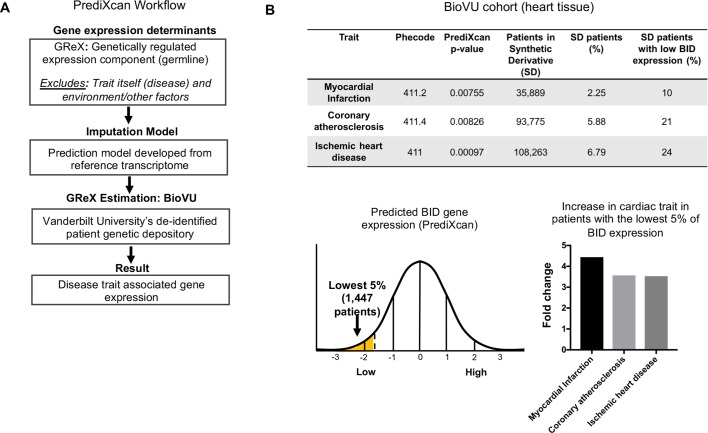
PrediXcan analysis of BID expression reveals a novel role in cardiac diseases.(A) Diagram of PrediXcan analysis workflow. PrediXcan estimates the genetically regulated component of gene expression (germline), excluding the impact of the disease itself and the environment on expression. (B) PrediXcan in a BioVU replication cohort of 29, 366 patients (in heart tissue). Patients were also binned by BID gene expression, with the lowest 5% analyzed for incidence of the cardiac traits discovered by PrediXcan. A total of 1447 patients encompassed the lowest 5% in BID expression. Myocardial infarction had the highest increased incidence, represented by graph for fold change in these patients compared to all Vanderbilt Synthetic Derivative (SD) patients (1,593,350 records). P-values were determined by logistic regression with disease status as response variable and imputed gene expression as predictor.